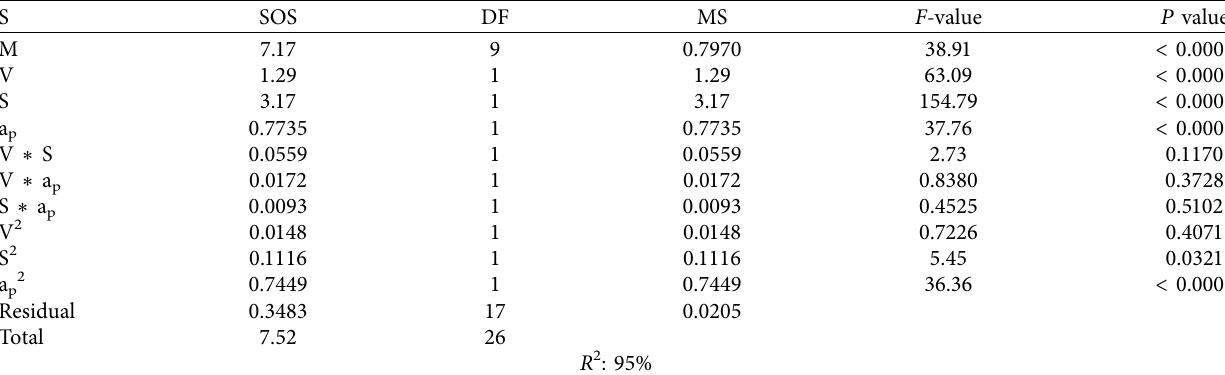
Table 3: ANOVA: roughness